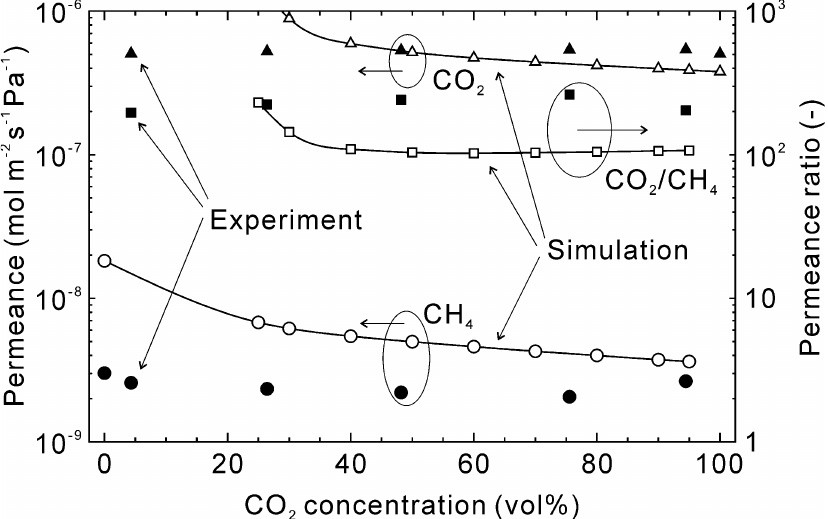
Figure 9. Influence of the CO 2 concentration on the permeation properties of the CHA-type zeolite membrane with Si/Al = 18.2 at 303 K. The permeation properties were calculated at the total pressure of 300 kPa, and experimental data were taken from [28].